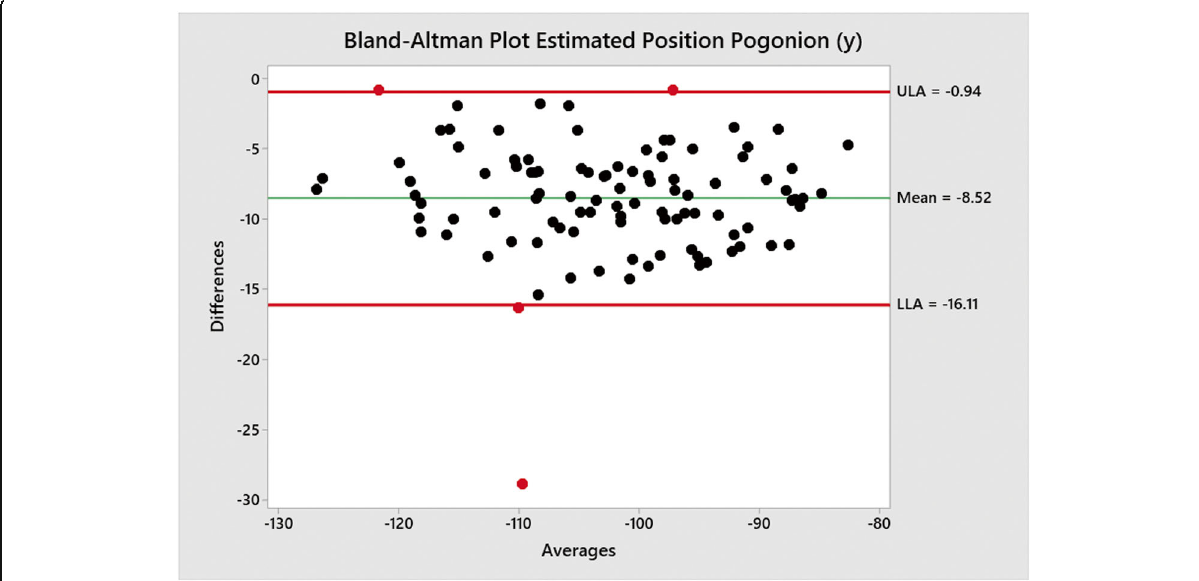
Fig. 5 Bland-Altman plot (estimated – traced of negative measured positions) between traced position of Pog ( y ) co-ordinate and estimated position by Sassouni+ analysis versus mean (average); the mean difference and limits of agreement are shown. There appears to be one outlier with a mean value of − 109.8 and for which there was a difference of −